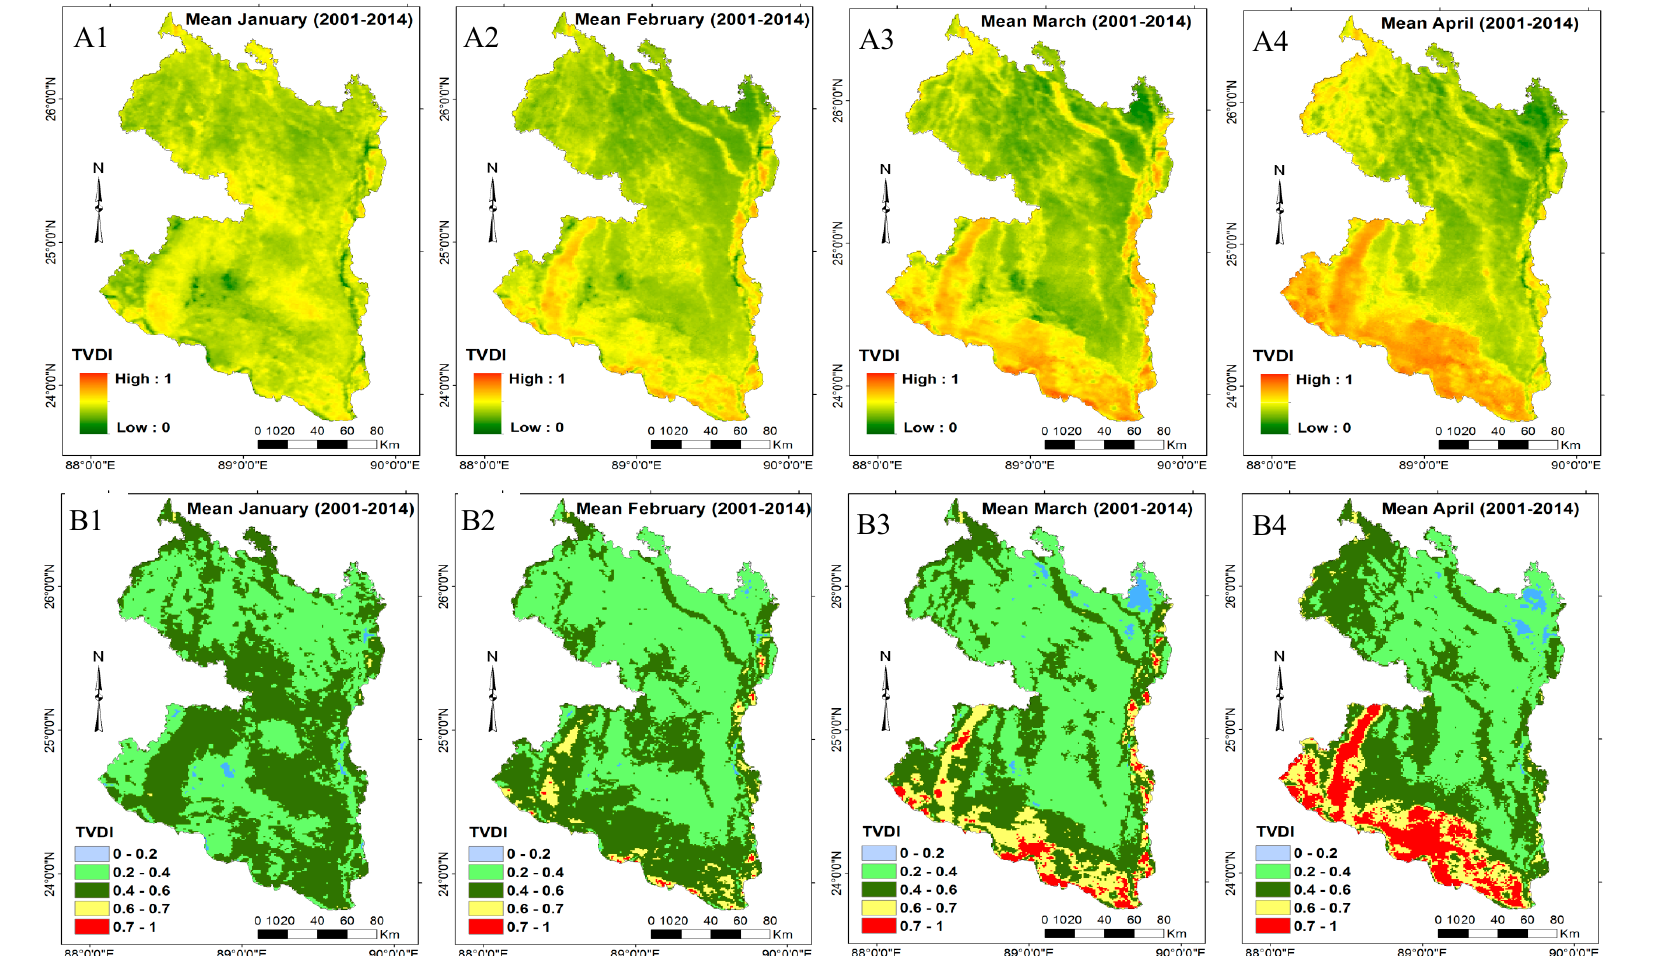
Figure 3. Monthly mean spatial distribution of the Temperature Vegetation Dryness Index (TVDI), for January, February, March, and April over 14 years (2001–2014) ( 3A ): stretched and ( 3B ): classified).